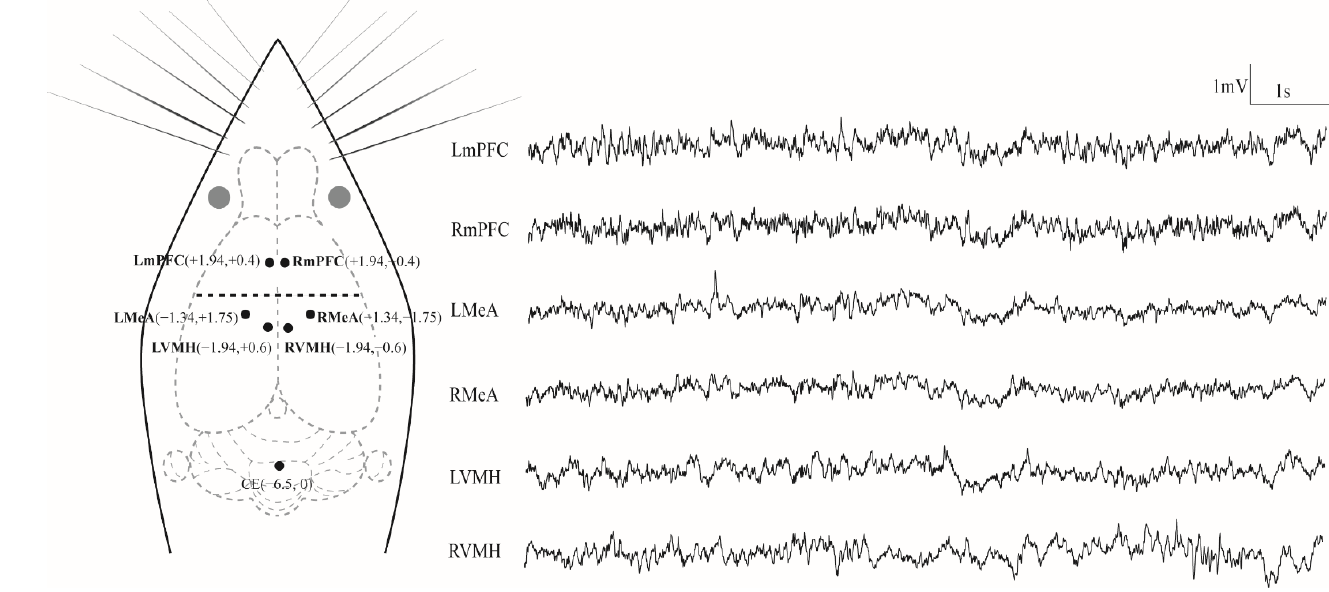
Figure 1. Electrode placements and 10 s of typical LFP tracings for each channel. LmPFC, RmPFC, LMeA, RMeA, LVMH and RVMH represent the left and right medial prefrontal cortex, medial amygdala and ventromedial hypothalamus, respectively, while CE denotes the reference electrode implanted above the cerebellum. The grey circles denote the eyes of the animal.